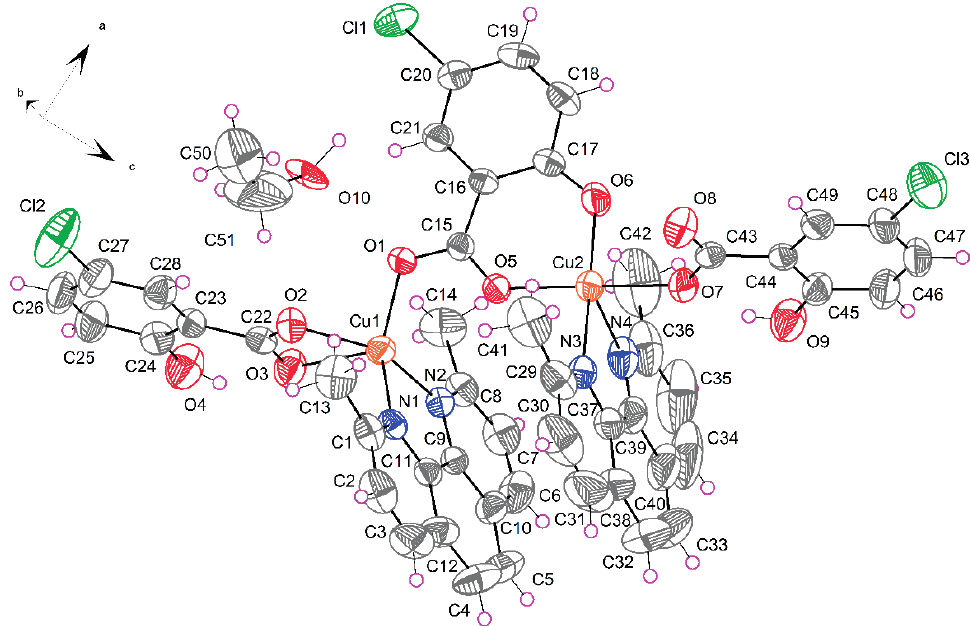
Figure 4. Perspective view of complex 3 , with the atom numbering scheme. Thermal ellipsoids are drawn at the 50% probability level.